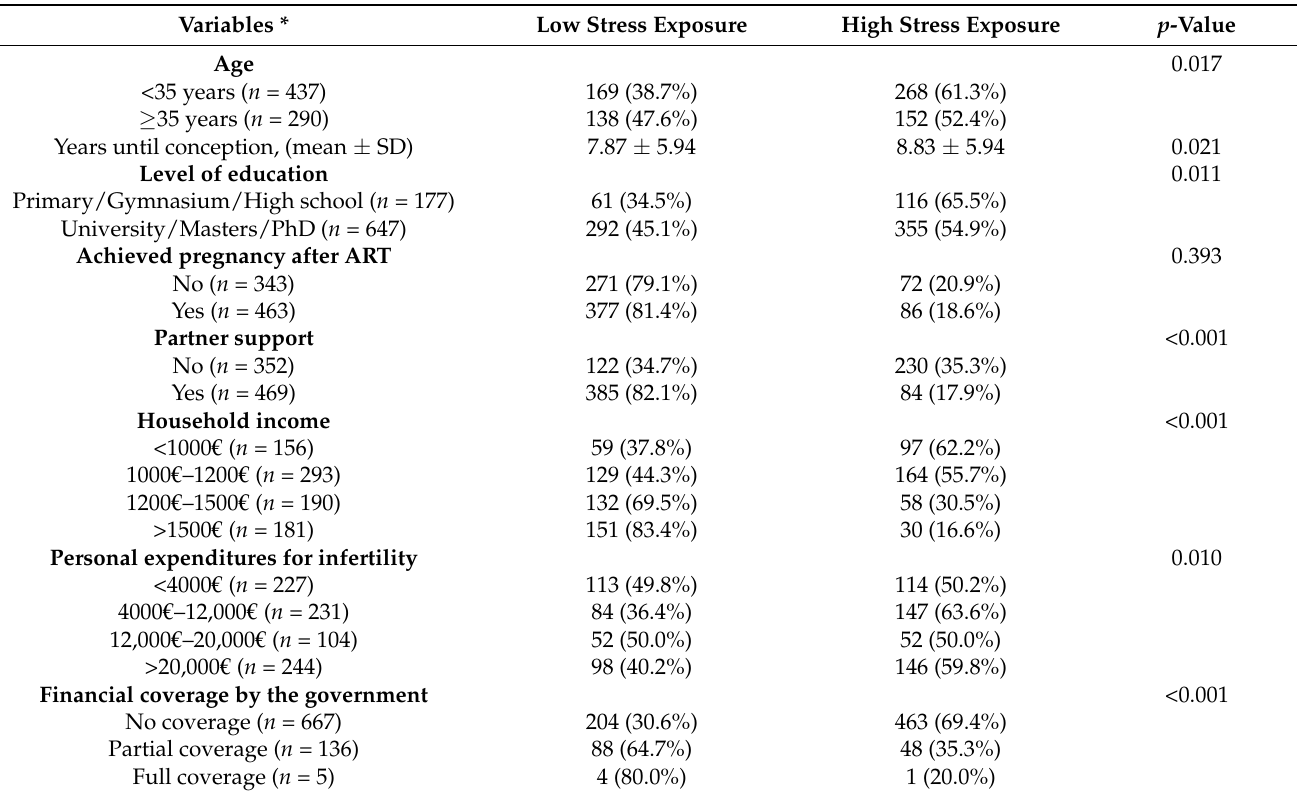
Table 1. Characteristics of women with infertility issues based on the level of stress they